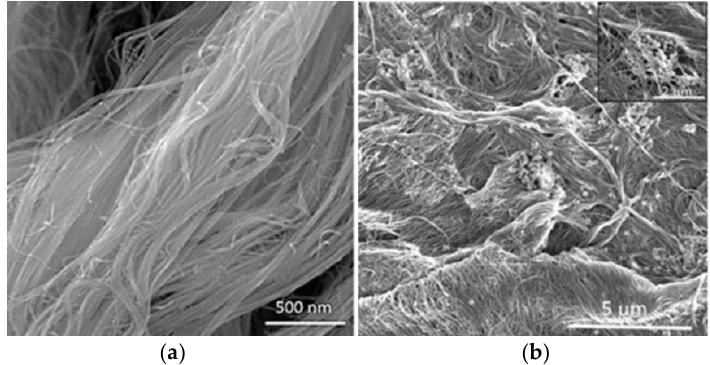
Figure 2. SEM images of carbon nanotube structures: ( a ) pure and ( b ) cast on PVDF membrane. Reprinted from [87], with permission from Elsevier.